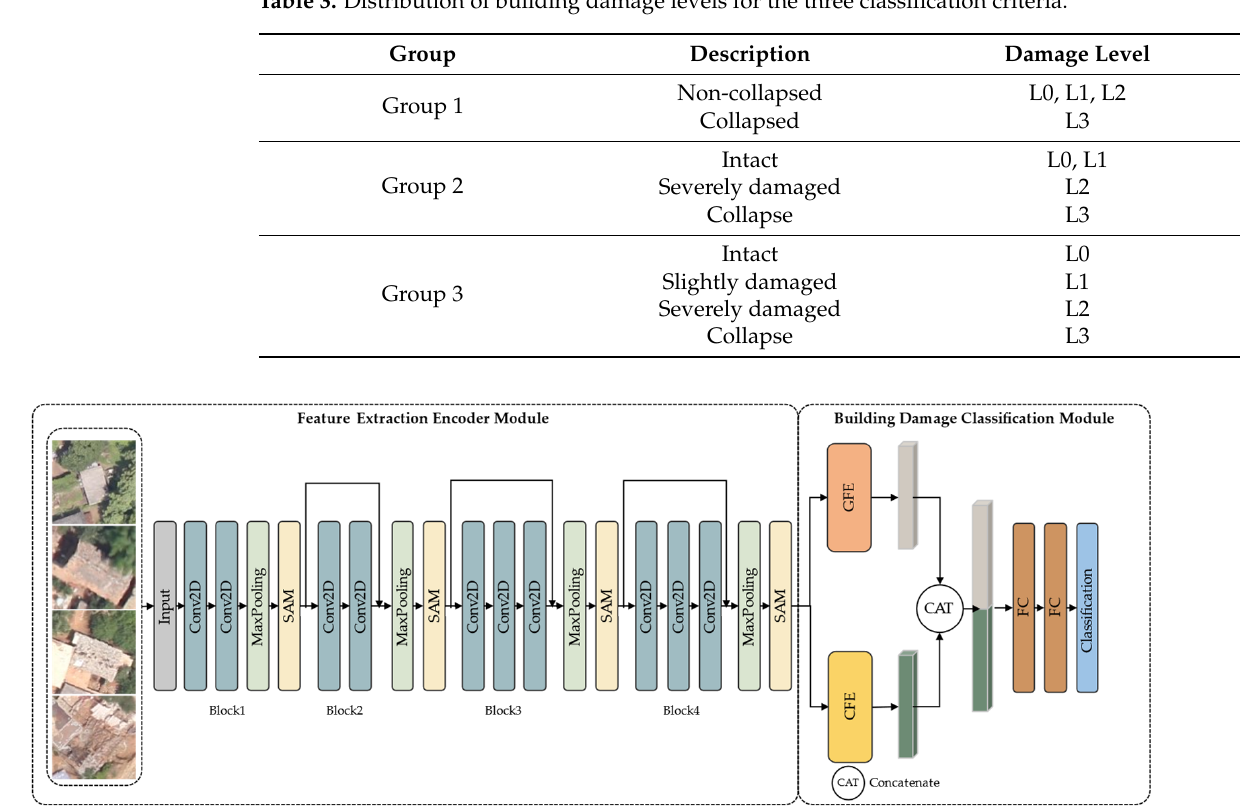
4 of 15 Table 3. Distribution of building damage levels for the three classification criteria. Group